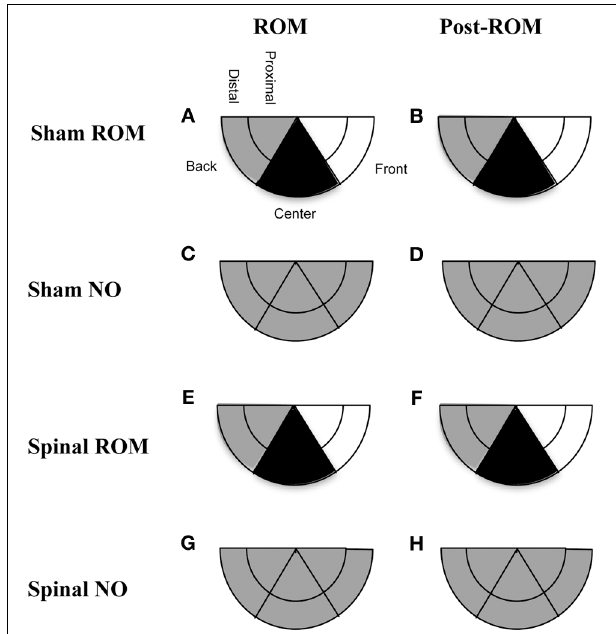
FIGURE 7 | Summary of changes in forelimb trajectories for sham and spinal P10 rats by ROM restriction condition. Changes in limb trajectories are show for sham subjects that experienced ROM restriction (A,B) , shams that did not receive ROM restriction (C,D) , spinal subjects that received ROM restriction (E,F) , and spinal subjects that did not receive ROM restriction (G,H) . The shaded regions reflect an increase (white), maintenance (gray), or decrease (black) from baseline within that trajectory area during the designated time